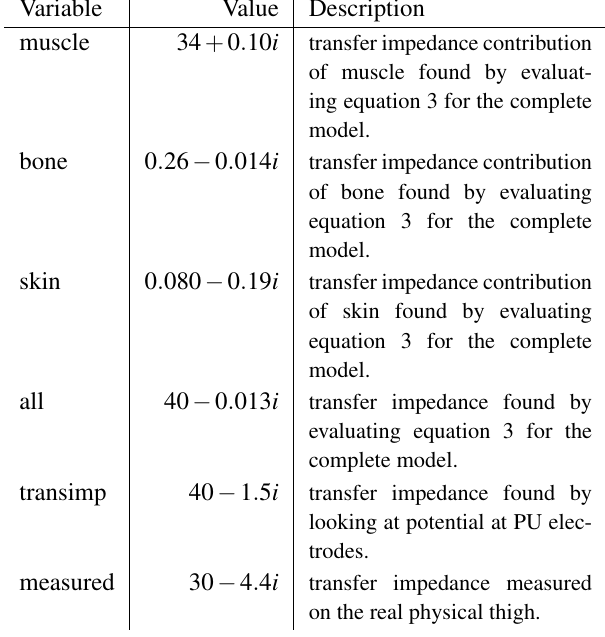
Tab. 2: Numerical results of our experiment. The difference between transimp and measured is probably due to the fact that our muscle tissue parameters are not anisotropic as they should have